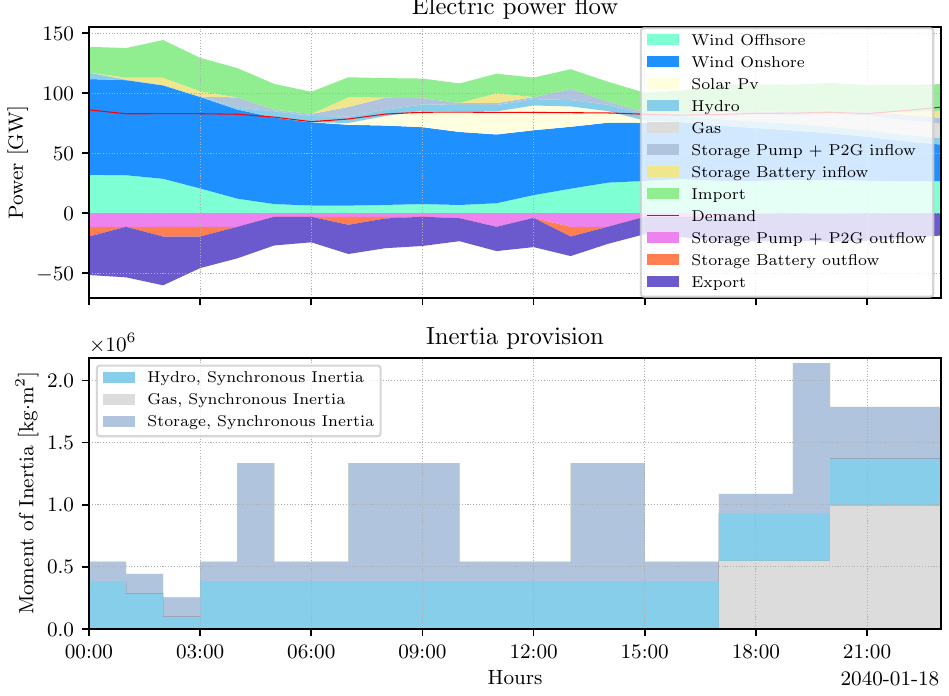
Figure 5. Visualisation of a full day of the NT scenario without considering inertia constraints. The top subplot illustrates results of the power output flows, and the bottom subplot shows the supplied moment of inertia